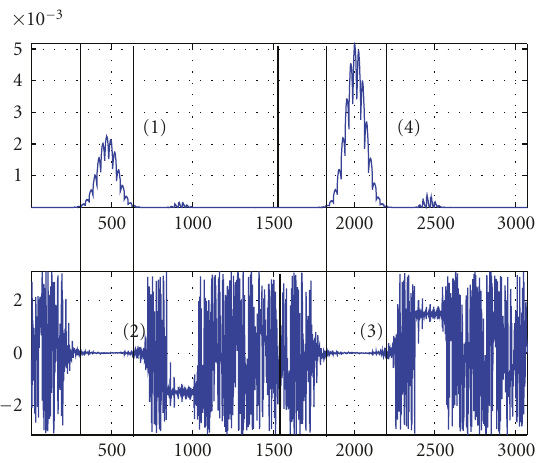
Figure 14: DOA estimation (cross-section for various o ff sets). Table 1: True and estimated values of polarization parameters of wave 1 and wave